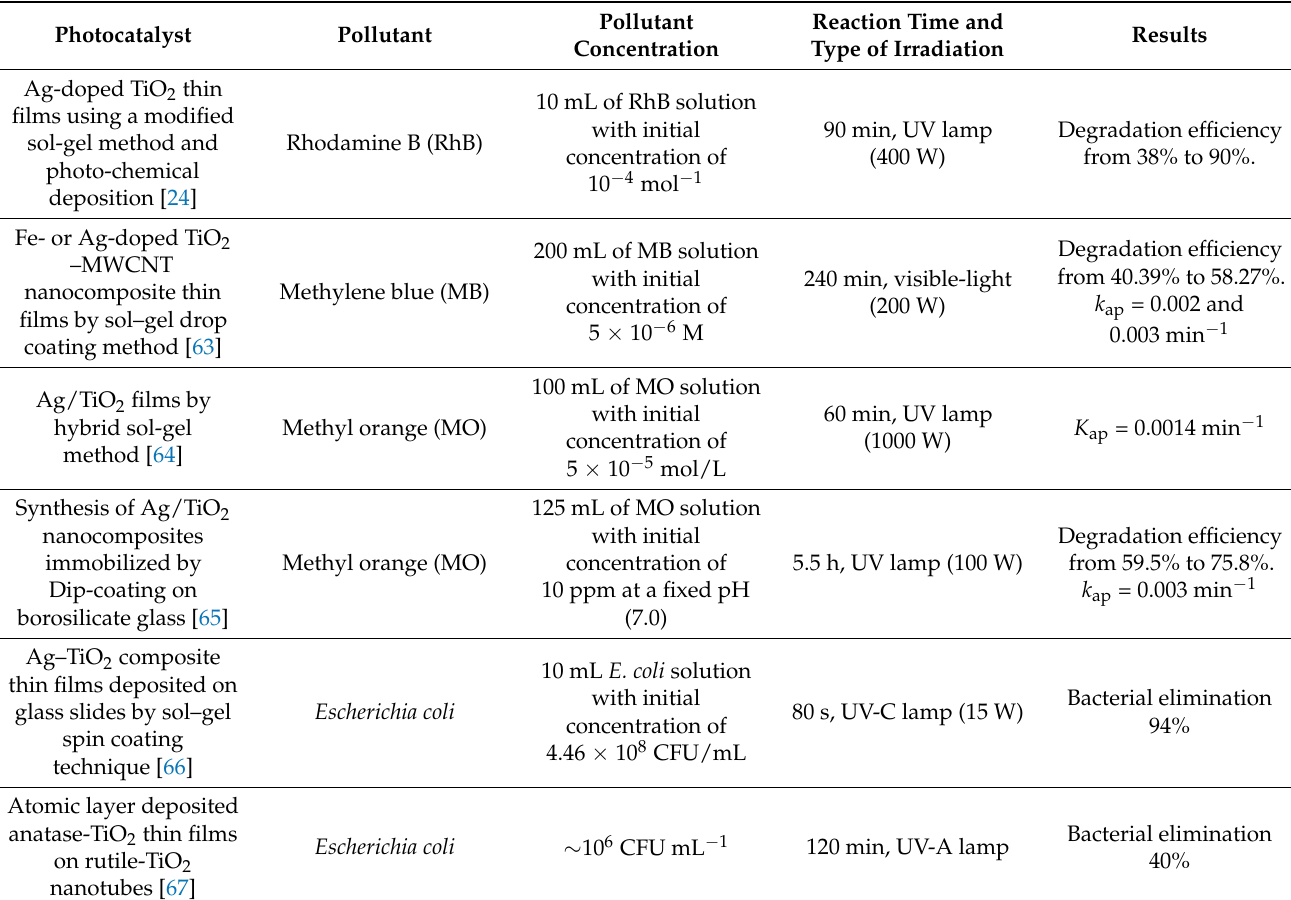
Table 1. Research on dye degradation and disinfection by